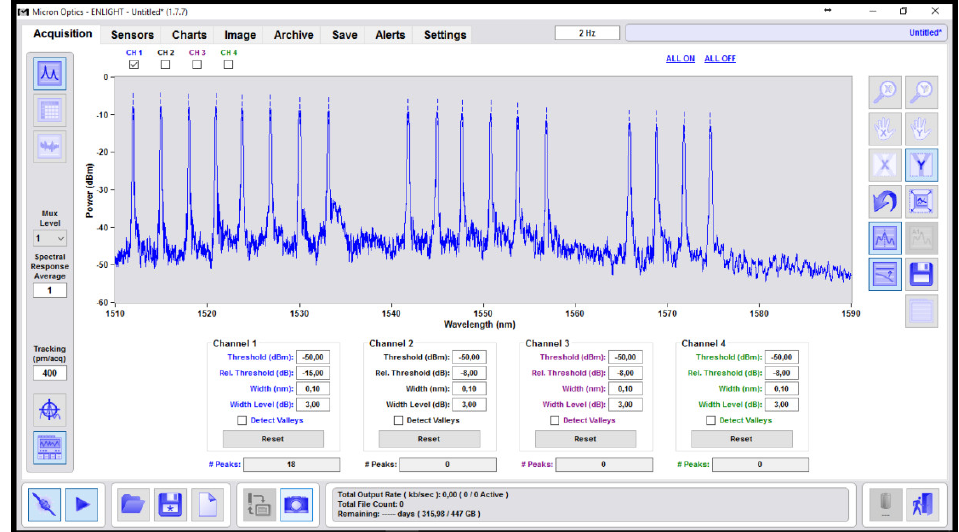
Figure 5. Spectrum of 18 FBGs used as temperature sensors.